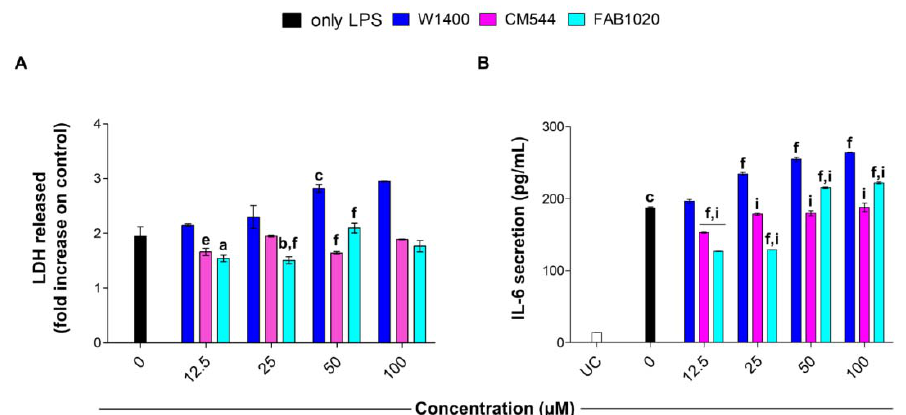
Figure 4. Cytotoxicity and interleukin ‐ 6 secretion in LPS ‐ stimulated human monocytes in the presence of increasing concentrations of 1400W, CM544 and FAB1020 after 24 h. ( A ) Bars represent the amount of LDH released in the presence of compounds (0–100 μ M) as the fold increase com ‐ pared to control samples (untreated cells, not shown) is set to 1. a = p < 0.01, b = p < 0.001 and c = p < 0.0001 between LPS ‐ stimulated cells and LPS ‐ stimulated cells treated with compounds. d = p < 0.01, e = p < 0.001 and f = p < 0.0001 between LPS ‐ stimulated cells treated with 1400W, CM544 or FAB1020 at the same concentration. ( B ) Bars show the amount of IL ‐ 6 released in the same condition of the LDH assay. UC = untreated cells. c = p < 0.0001 between LPS ‐ stimulated cells and untreated cells. d = p < 0.01, e = p < 0.001 and f = p < 0.0001 between LPS ‐ stimulated cells and LPS ‐ stimulated cells treated with compounds; g = p < 0.01, h = p < 0.001 and i = p < 0.0001 between LPS ‐ stimulated cells treated with 1400W and LPS ‐ stimulated cells treated with CM544 and FAB1020 at the same con ‐ centration.